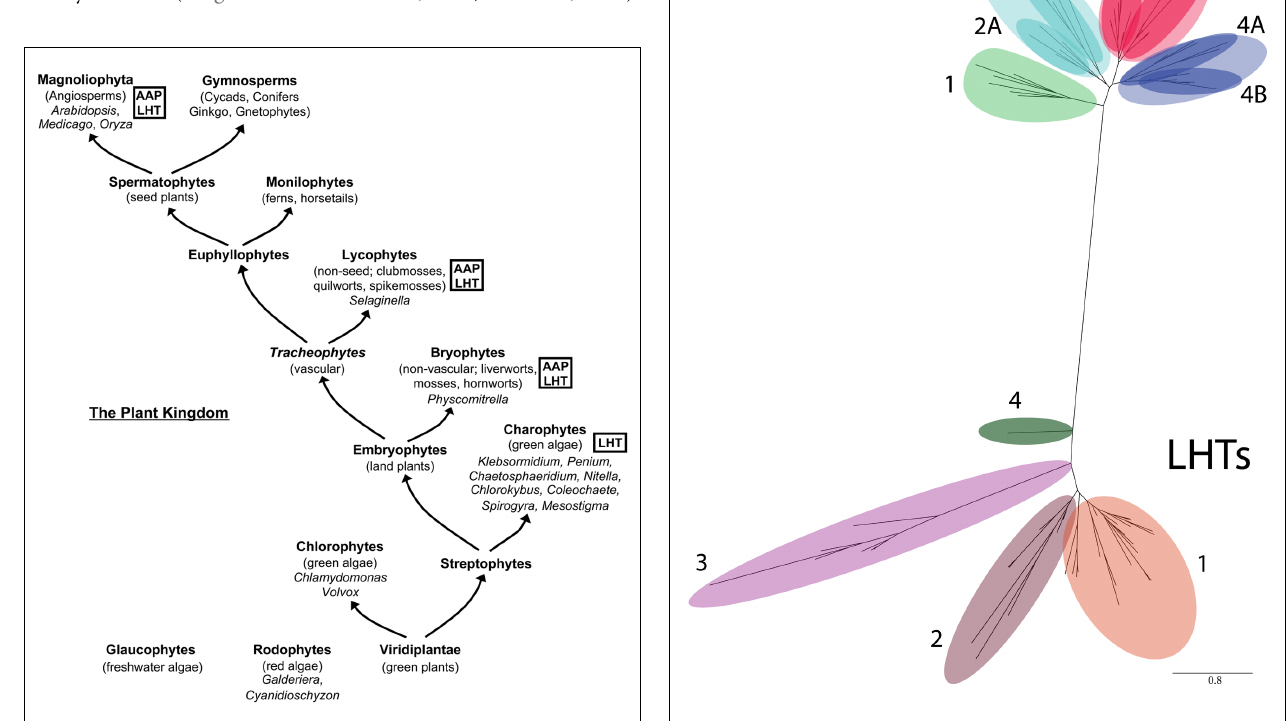
FIGURE 1 | Simplified overview of the plant kingdom and analyzed genera. Taxa containing AAPs and/or LHTs are marked. Note, that genomes of gymnosperms and monilophytes have not been used for the analysis.